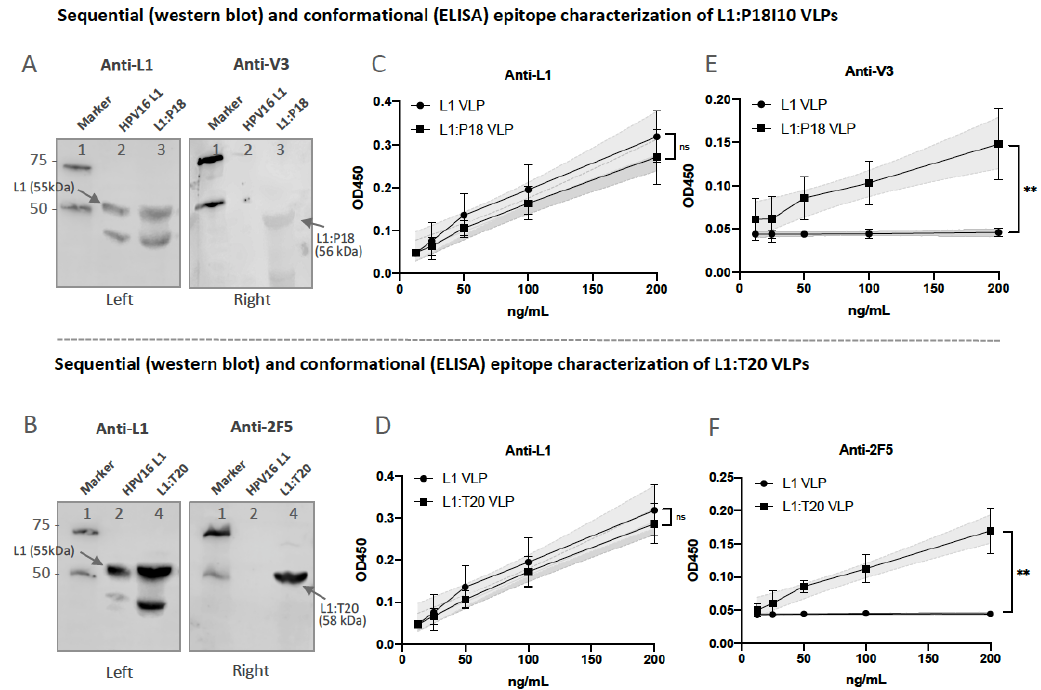
Figure 5. Presentation of HPV-16 and HIV-1 epitopes. ( A , B ) Sequential epitope detection of chi- meric L1:P18I10 and L1:T20 VLPs. The purified L1:P18I10 and L1:T20 VLPs were analyzed by